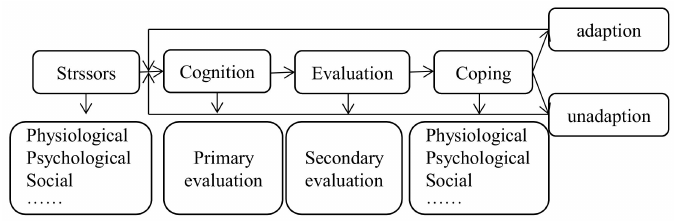
Figure 1. The Cognitive Phenomenological–Transactional Model